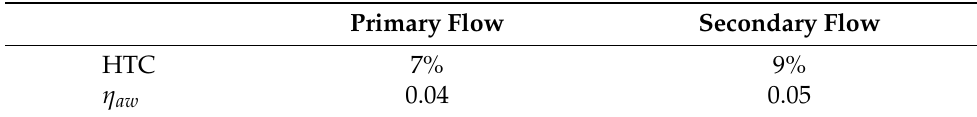
Table 1. Uncertainty of wall heat transfer characterization.